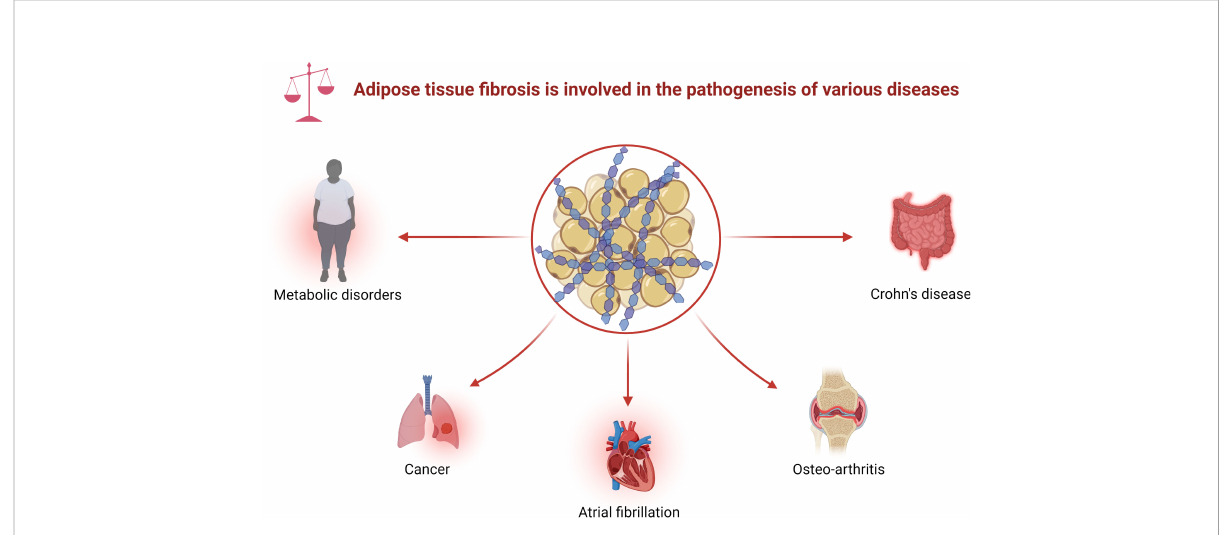
FIGURE 1 Adipose tissue fi brosis is involved in the pathogenesis of various diseases. Adipose tissue fi brosis, de fi ned as excessive deposition of ECM in adipose tissue, appears in various diseases, including metabolic disorders, cancer, atrial fi brillation, osteoarthritis, and Crohn ’ s disease. ECM, extracellular